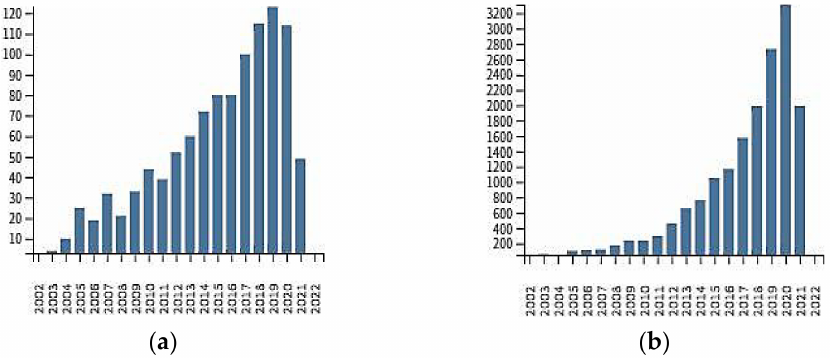
Figure 2. PHM citation report for renewable energy systems results from the web of science core collection between 2002 and 2021. ( a ) Total publication per year; ( b ) Sum of times cited by year.